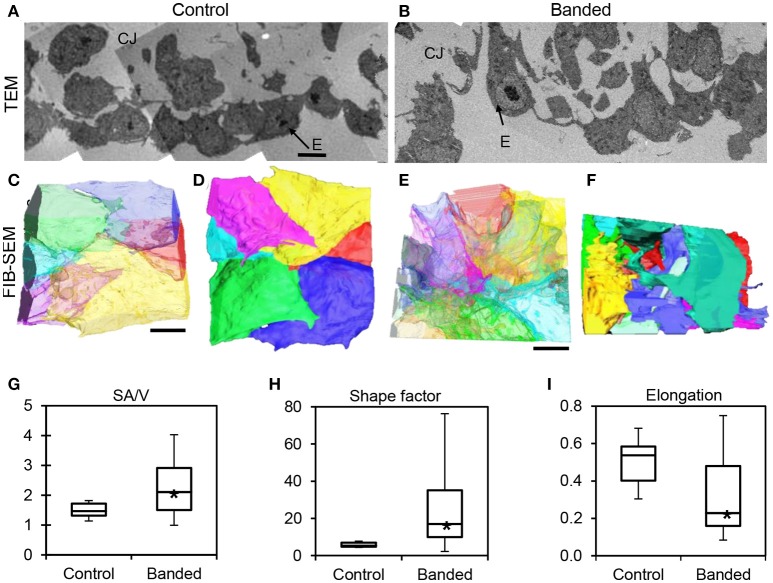
Electron microscopy analysis of endocardium remodeling. Stitched TEM images of the endocardium and adjacent cardiac jelly at 1700x (A,B), and the corresponding 3D FIB-SEM reconstructions of endocardial cell segmentations from image stacks (C–F). Reconstructions display each cell in a different color and are orientated to view the endocardial-lumen edge with translucently colored cells (C,E) and the endocardial-cardiac jelly interface edge with opaquely colored cells (D,F) from an example control embryo (A,C,D) and an example banded embryo (B,E,F). Box plots showing differences in endocardial cell geometry, quantified from 3D segmentations of FIB-SEM images, with surface area-to-volume ratio, SA/V (G), shape factor (H), and elongation factor (I). Boxes mark the upper and lower quartiles and whiskers mark the maximum and minimum values for each parameter. Asterisks denote statistically significant differences between experimental and control samples (p < 0.01). CJ, cardiac jelly; E, endocardium. Scale bar = 5 μm.